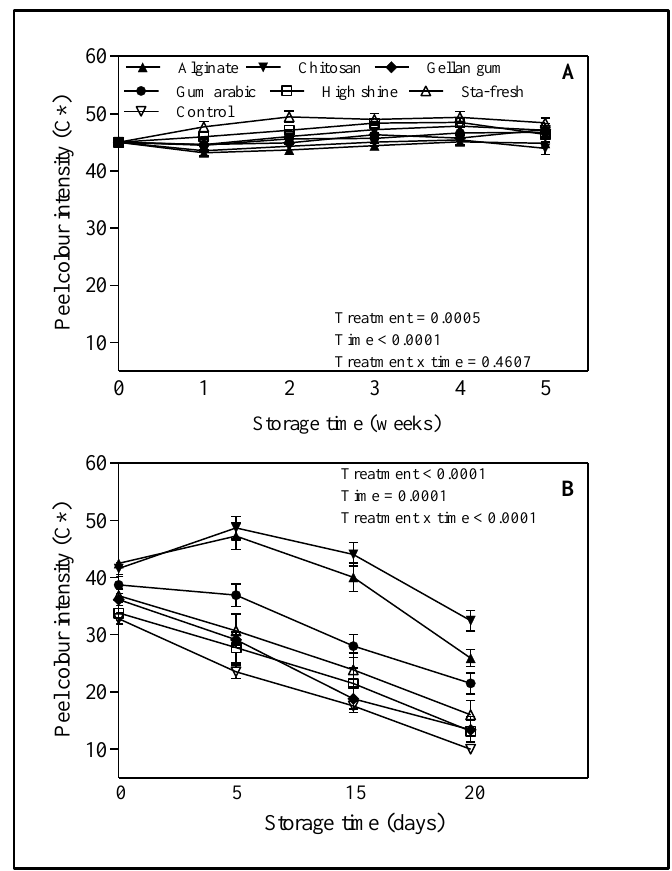
Figure 3. Peel color intensity (chroma; C*) in plums (‘African Delight™’) during ( A ) a simulated shipping period (cold storage; −0.5 ± 2 °C and 90 ± 5% RH for 5 weeks) and ( B ) shelf life (20 ± 2 °C and 75 ± 5% relative humidity (RH) for 20 d). Means ± standard errors presented. In other to determine the interaction effects, factorial ANOVA was performed for main factors; treatment and storage time separately for cold storage and shelf life periods.